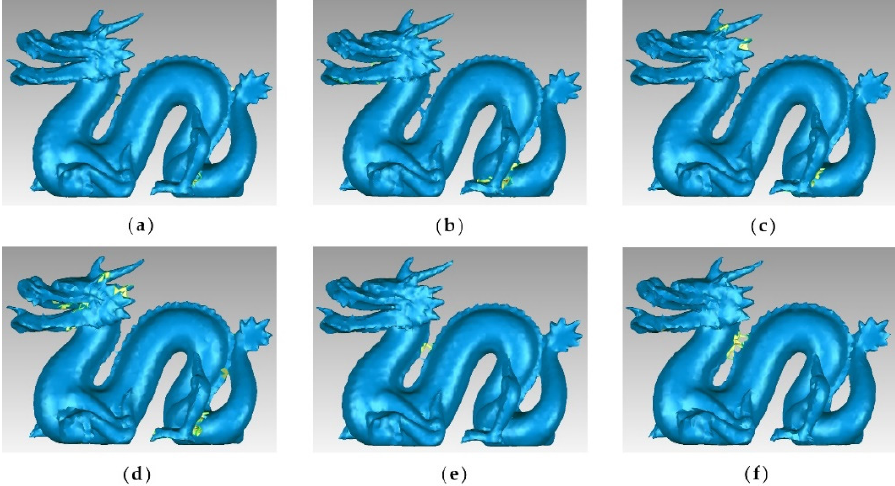
Figure 5. Encapsulated surfaces of point clouds corresponding to the buddha dataset: ( a ) MIWSA; ( b ) random algorithm; ( c ) normal algorithm; ( d ) voxel algorithm; ( e ) k-means algorithm; ( f ) curvature algorithm.